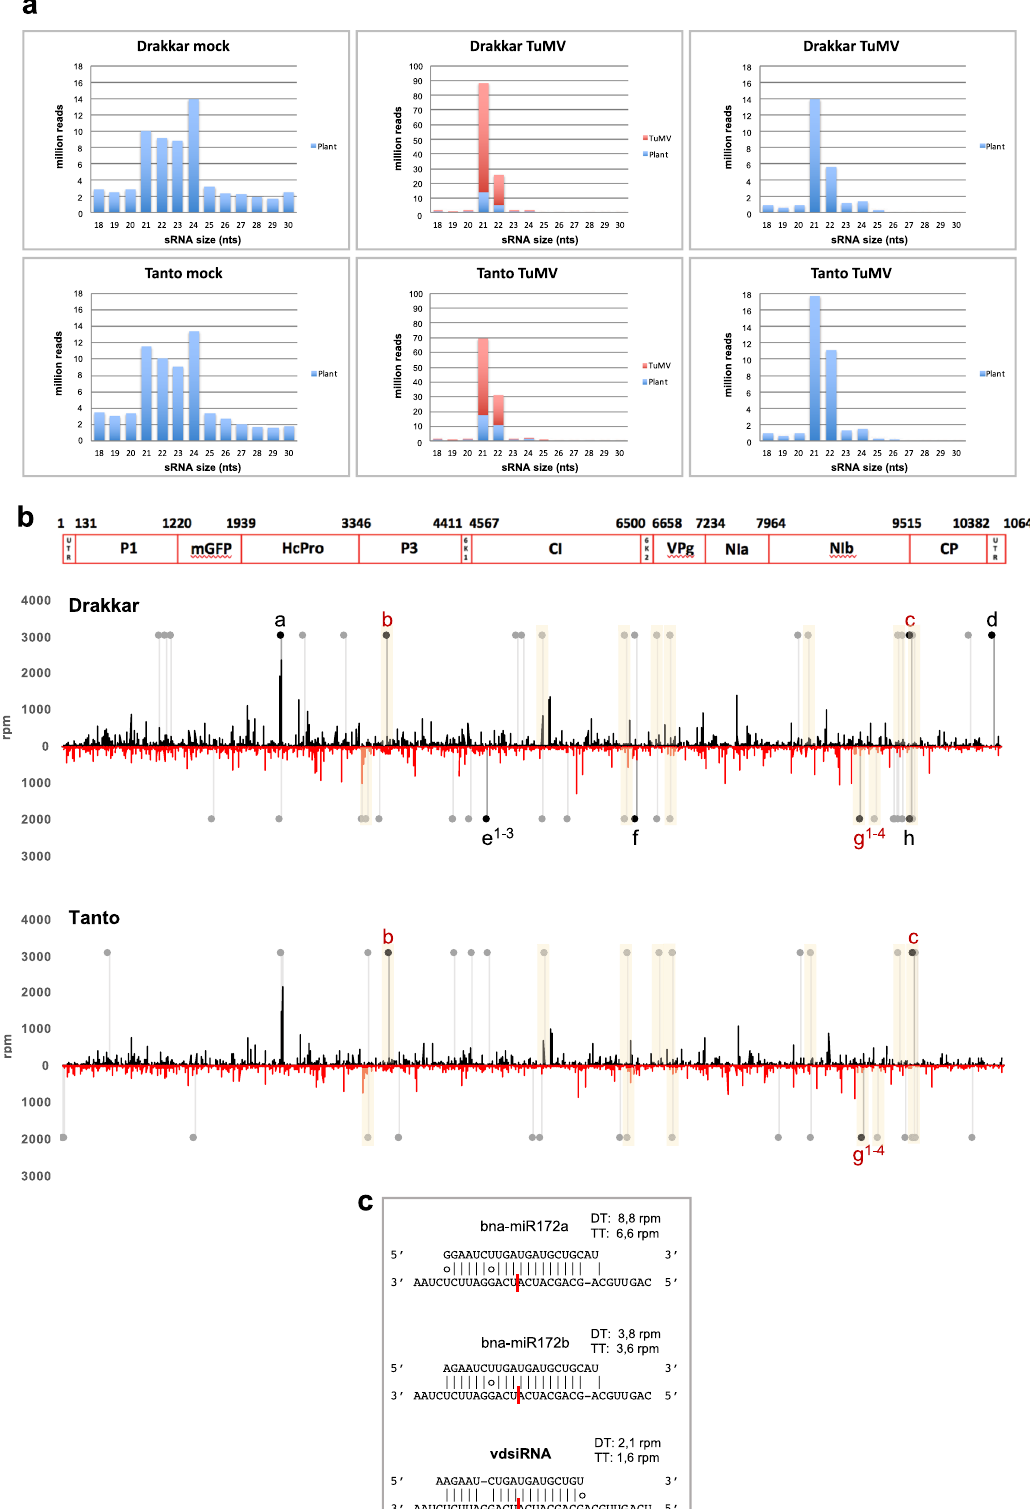
PROMOTER BINDING PROTEIN LIKE (SPL) that were targeted by miR156d,e,f in Tanto (Supplementary Data 5). Collectively, our degradome data indicate that miRNA – mRNA pairs previously reported in Arabidopsis and other species were also active in B. napus and suggest a functional role of miRNAs in speci fi c gene regulation during